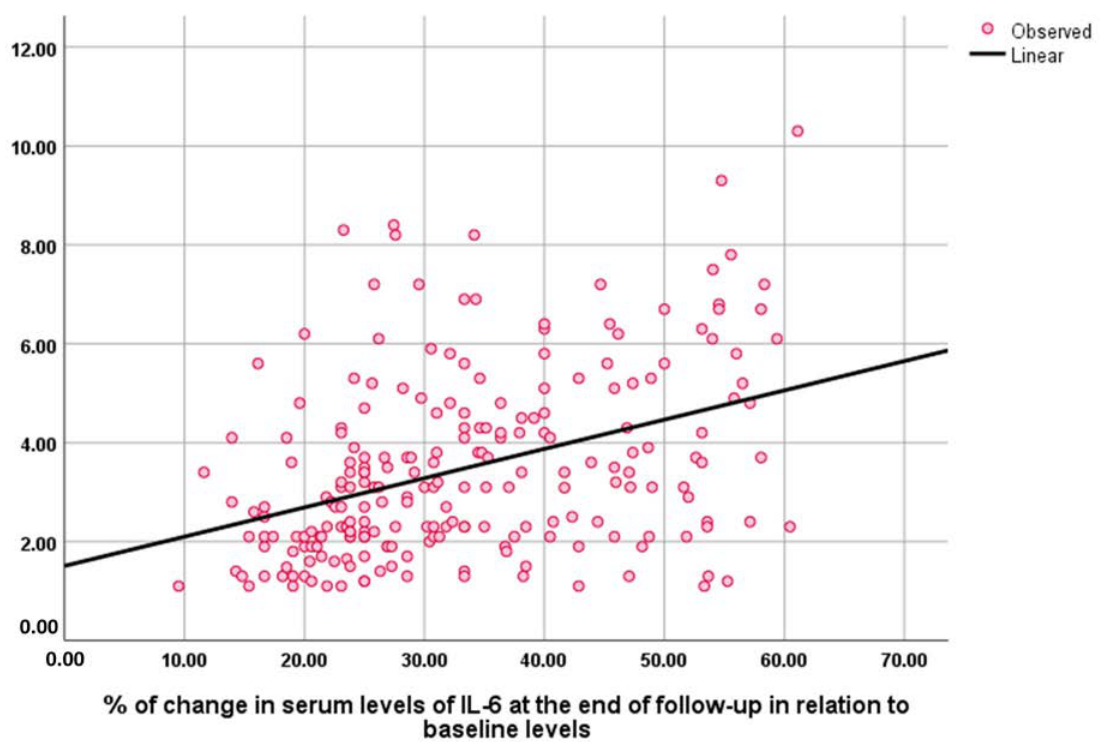
Figure 4. Correlation between the percentage of change in NESPY and serum levels of IL-6 at the end of the follow-up in relation to baseline levels.